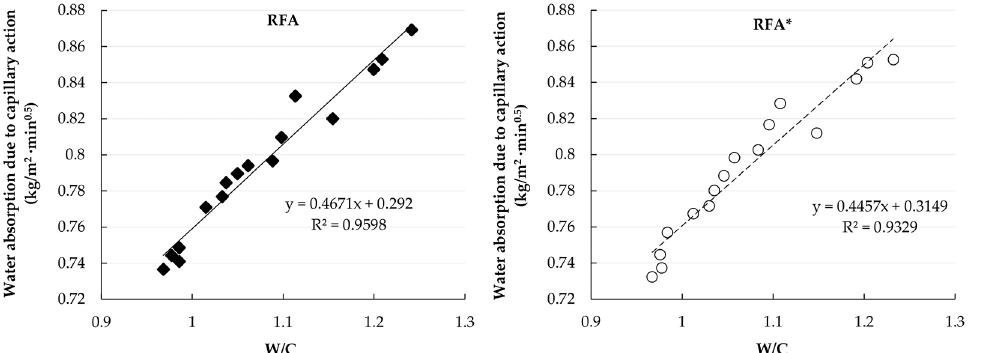
Figure 15. Correlation between water absorption and water/cement ratio.